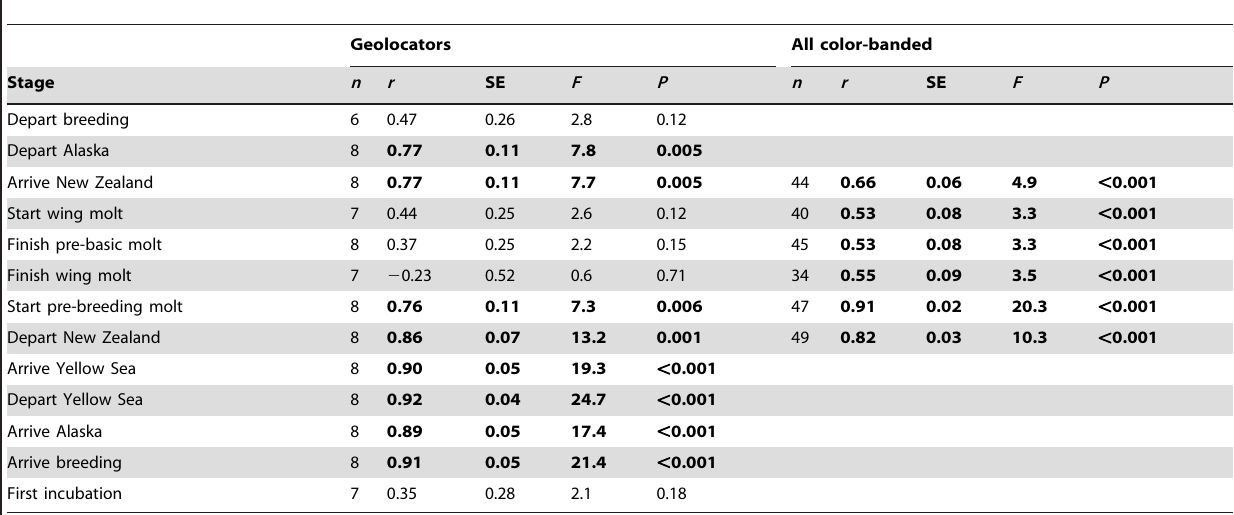
Table 1. Individual repeatability in timing of key events in the annual cycle of bar-tailed